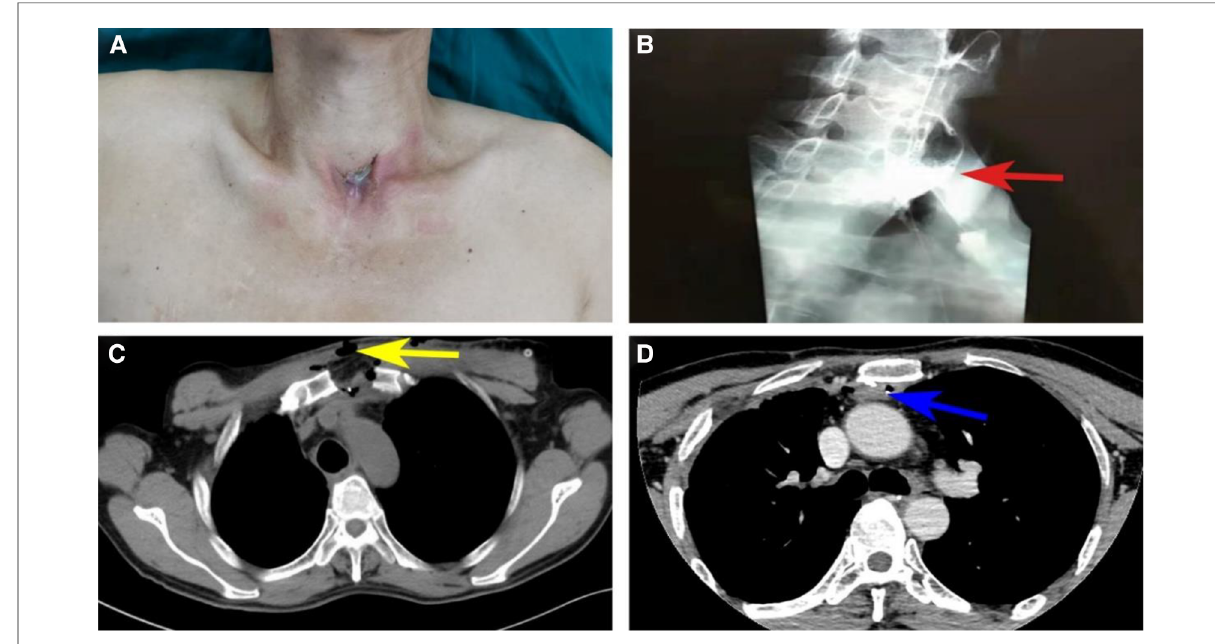
FIGURE 1 Preoperative visual inspection, esophagography and CT. ( A ) Visual inspection of external neck skin and esophageal cutaneous fi stula; ( B ) Left lateral view from a barium swallow shows ingested barium extravasated from a perforation (red arrows) into extraluminal space with the lower part of the esophagus not visible, indicating esophageal stenosis and fi stula. ( C ) CT shows the esophageal cutaneous fi stula (yellow arrows). ( D ) CT shows the lower end of esophageal stricture (blue arrows) in